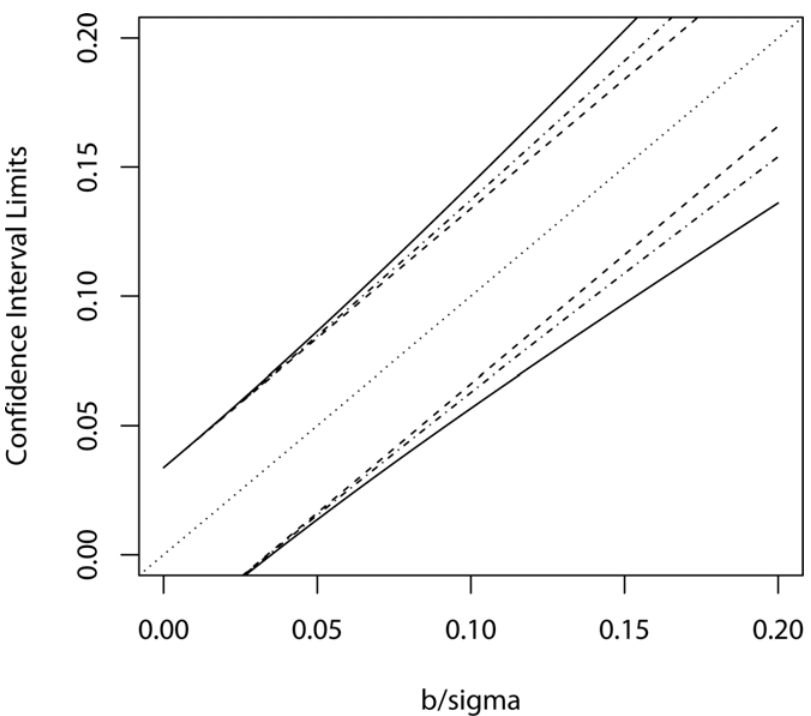
Fig 2. Effect of accounting for shared dosimetry errors on the length of standard errors in the high- sided calculations performed for the AVS study. The two dashed lines are based on ordinary least squares calculations and show the upper and lower bounds of a "na ï ve" confidence interval for slope parameter b (normalized by residual standard deviation, σ ) ignoring inhomogeneous or shared errors. The solid lines show the effect of accounting for both inhomogeneous and shared error in expanding the confidence limits. The dot-dash lines between the dashed and solid lines shows the effect of adjusting for inhomogeneous errors but where there are no shared errors (off diagonals of matrix K are